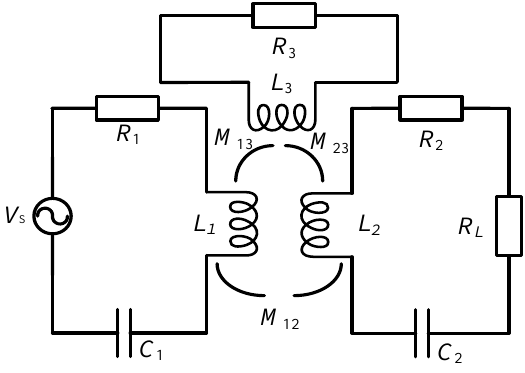
Figure 4. System equivalent circuit with metal plate.